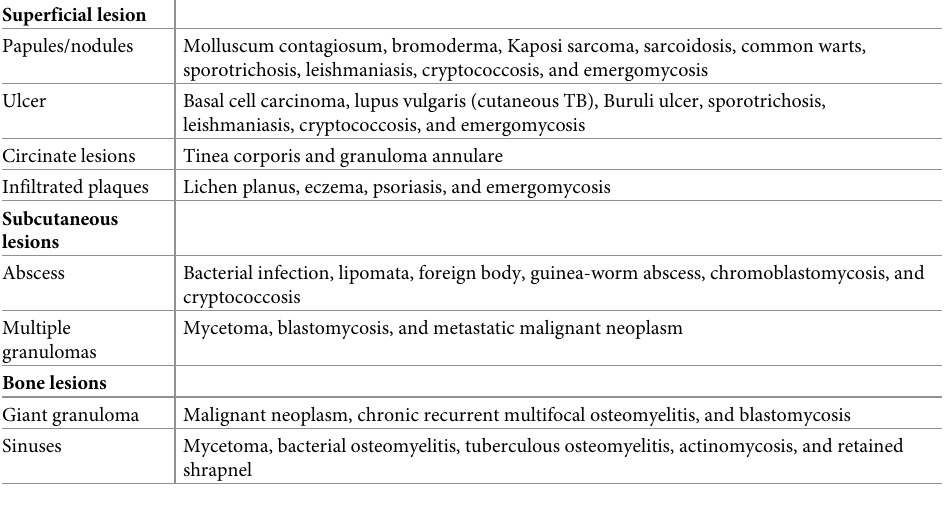
Table 2. Differential diagnosis of cutaneous, subcutaneous, and osseous manifestations of